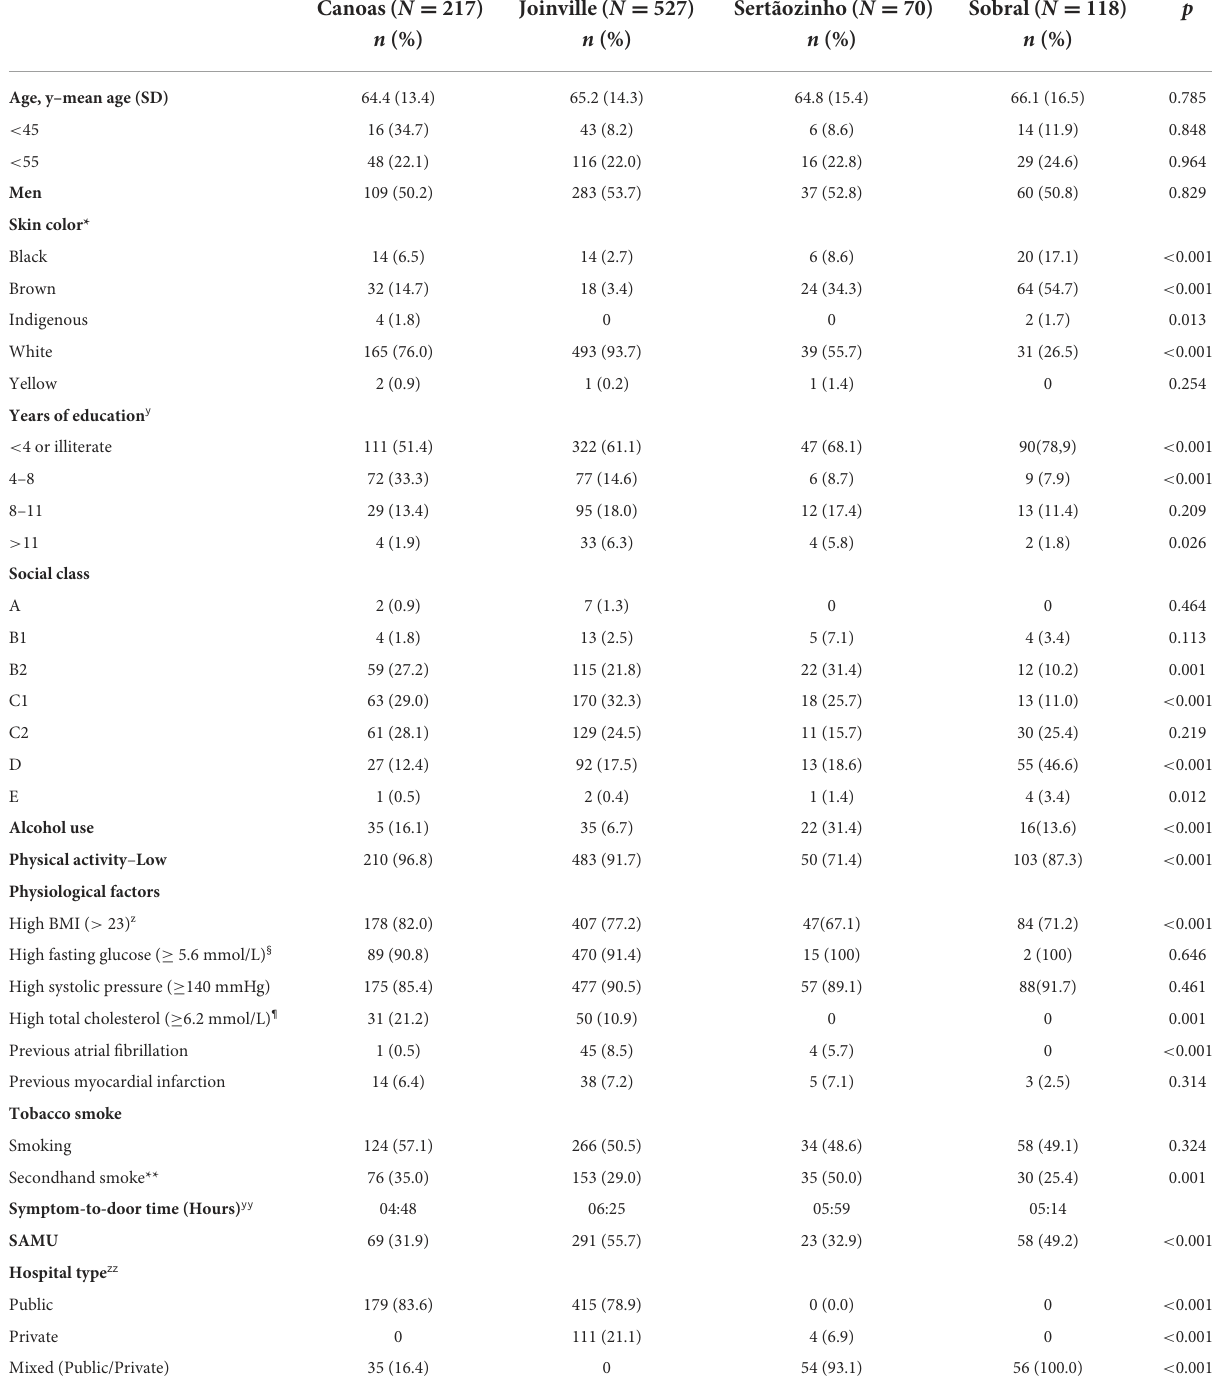
TABLE 1 Baseline demographic and socioeconomic data of patients, risk factors, and access to stroke assistance in four Brazilian cities. Canoas ( N = 217) Joinville ( N = 527) Sertãozinho ( N = 70) Sobral ( N =